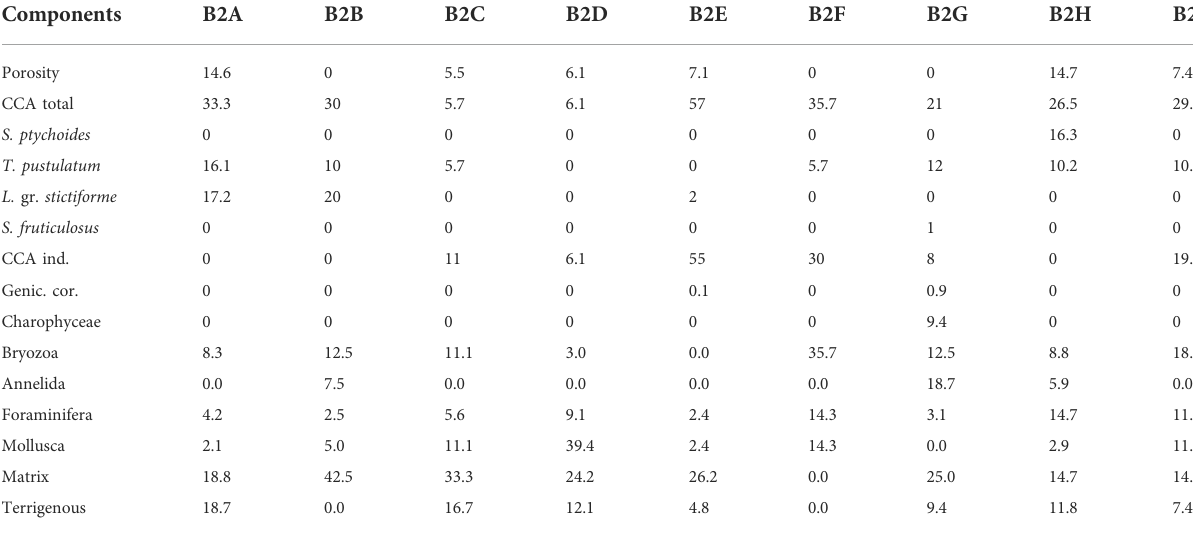
TABLE 4 Point counting results for Bogliasco core